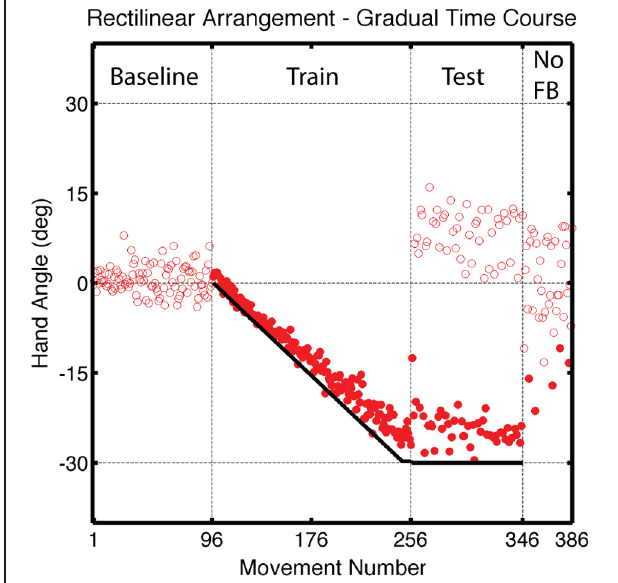
FIGURE 9 | Group averaged endpoint hand angle across trials in Experiment 3. A vertical shift (black solid line) was introduced in an incremental manner during the Training Block, reaching a final value of 4cm (movements 97–256). Feedback was only provided for reaches to the training target location during the Test block (movements 256–226). Visual feedback was never provided in the final, No Feedback block. Filled circles represent movements to the training target location and open circles represent movements to other target